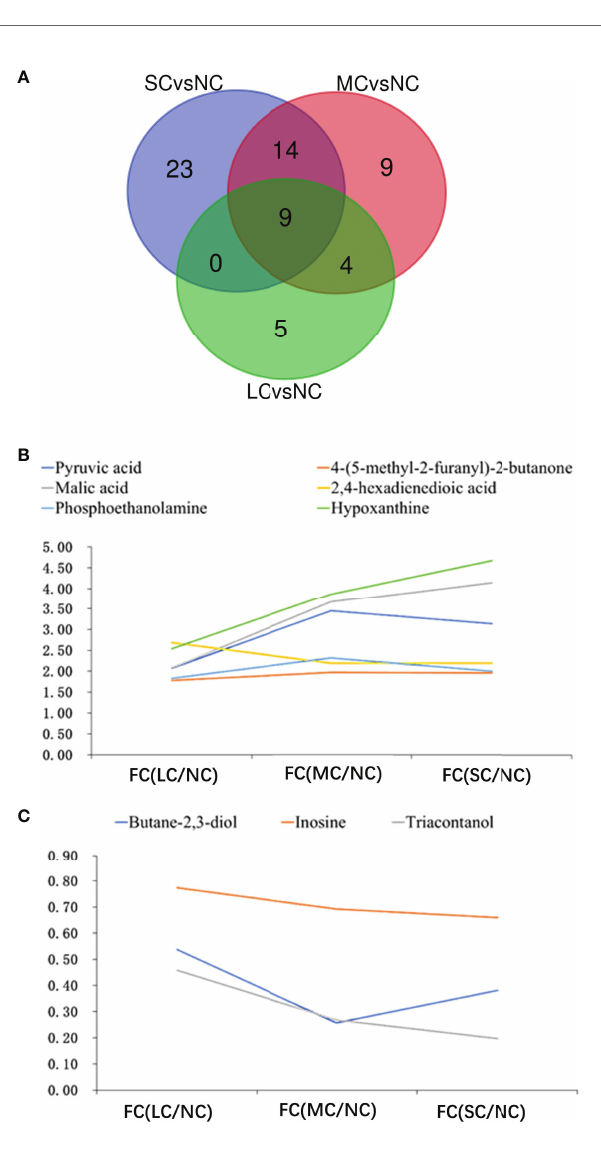
FIGURE 5 | Association analysis of differential metabolites in the three groups: Venn diagram of mutual differential metabolites (A) ; FC fi gures of mutual up- regulated metabolites (B) and down-regulated metabolites (C) in gills. In a, Green circle represents SCvsNC group, red circle represents MCvsNC group, blue circle represents LCvsNC group; the number in the fi gure represents the amount of different metabolites after intersection.